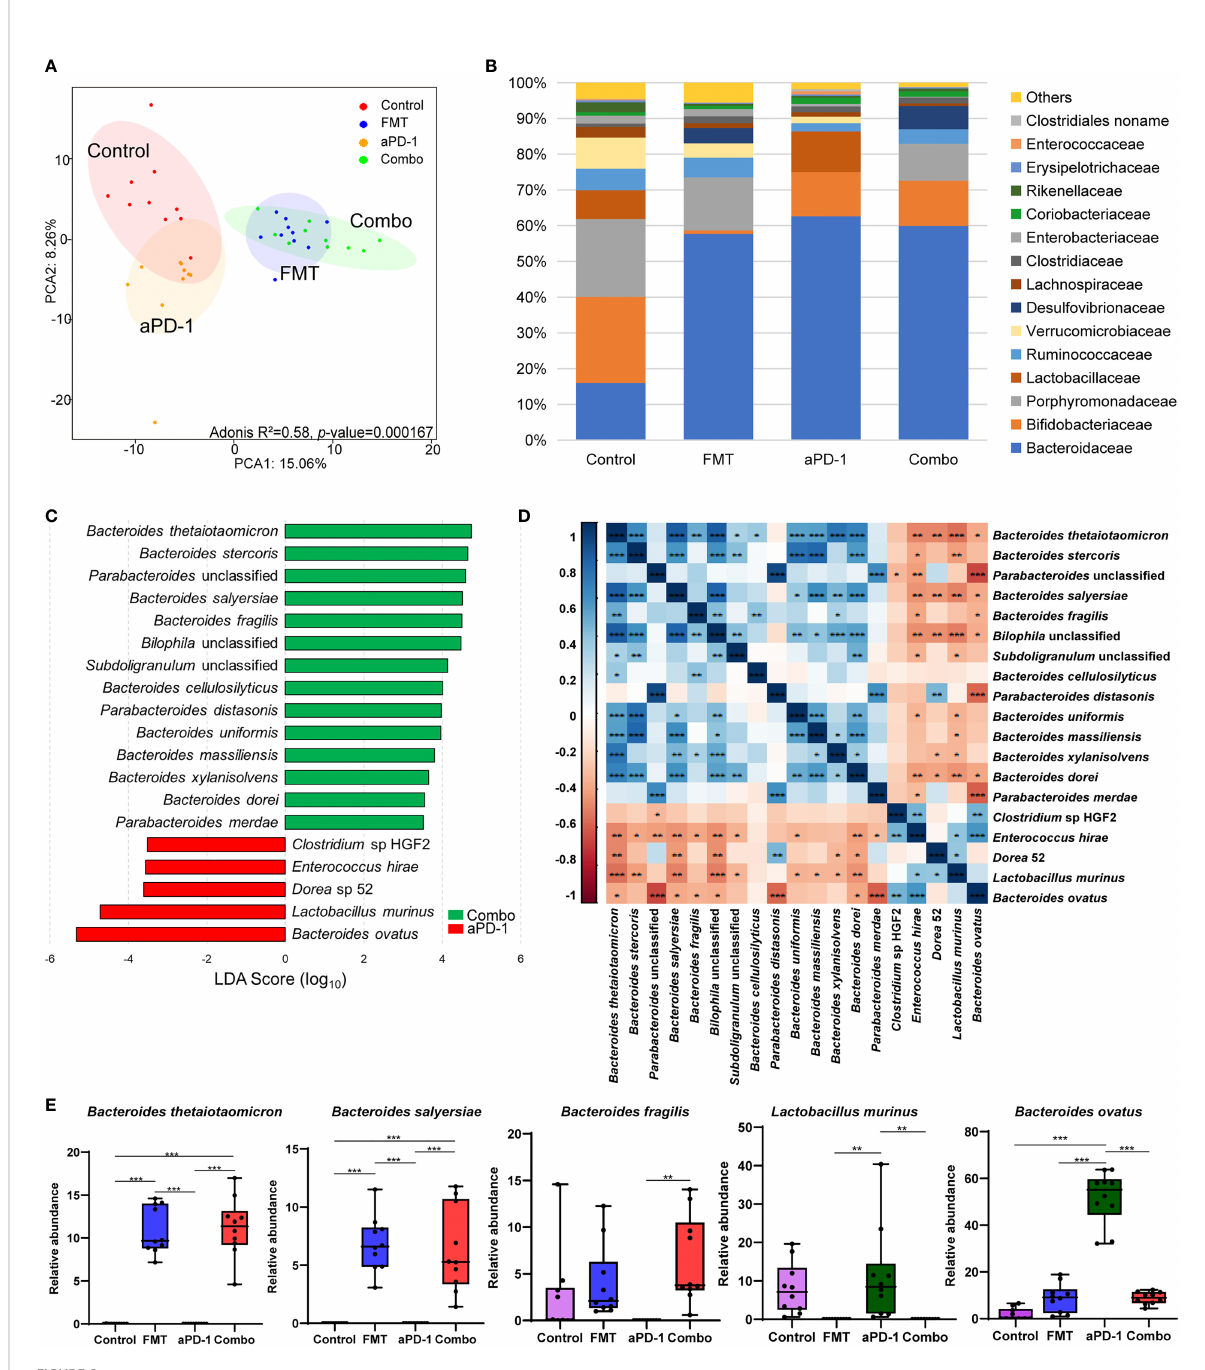
FIGURE 2 FMT altered the composition of gut microbiota in CT-26 tumor-bearing mice receiving anti-PD-1 therapy. (A) Principal components analysis (PCA) plot of the gut microbiota from mice. (B) Relative abundance of top 15 bacterial families in different groups. (C) LEfSe analysis showing differentially abundant bacterial species between FMT and Combo groups. (D) Heatmap showing the correlations of species signi fi cantly different between FMT and Combo groups. (E) Abundance of speci fi c species in different groups. Data are represented as mean ± SD. *, p -value < 0.05; **, p -value < 0.01; ***, p -value <